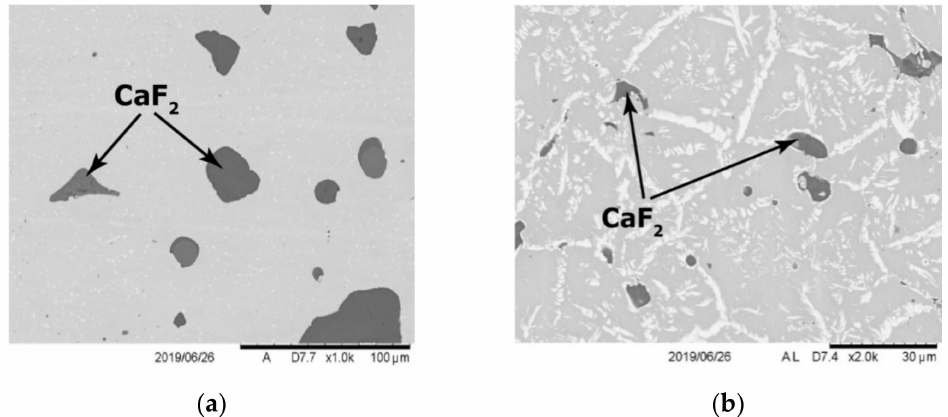
Figure 1. Structure of the material, wt.%: EP975 + 6CaF 2 ; ( a ) non-etched section; ( b ) etched section.